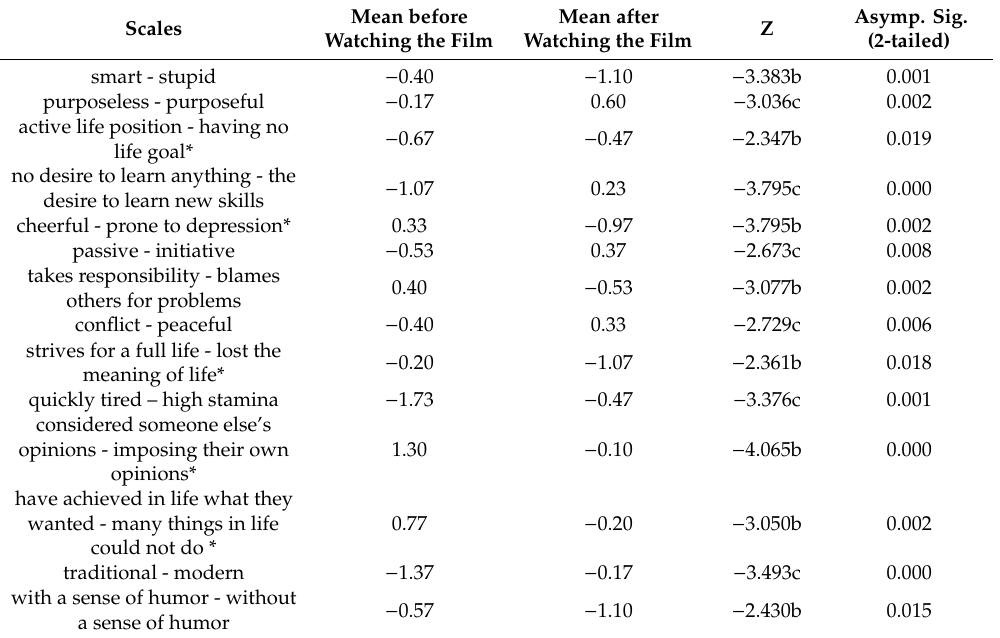
Table 2. Changes in assessments of elderly people after watching the film